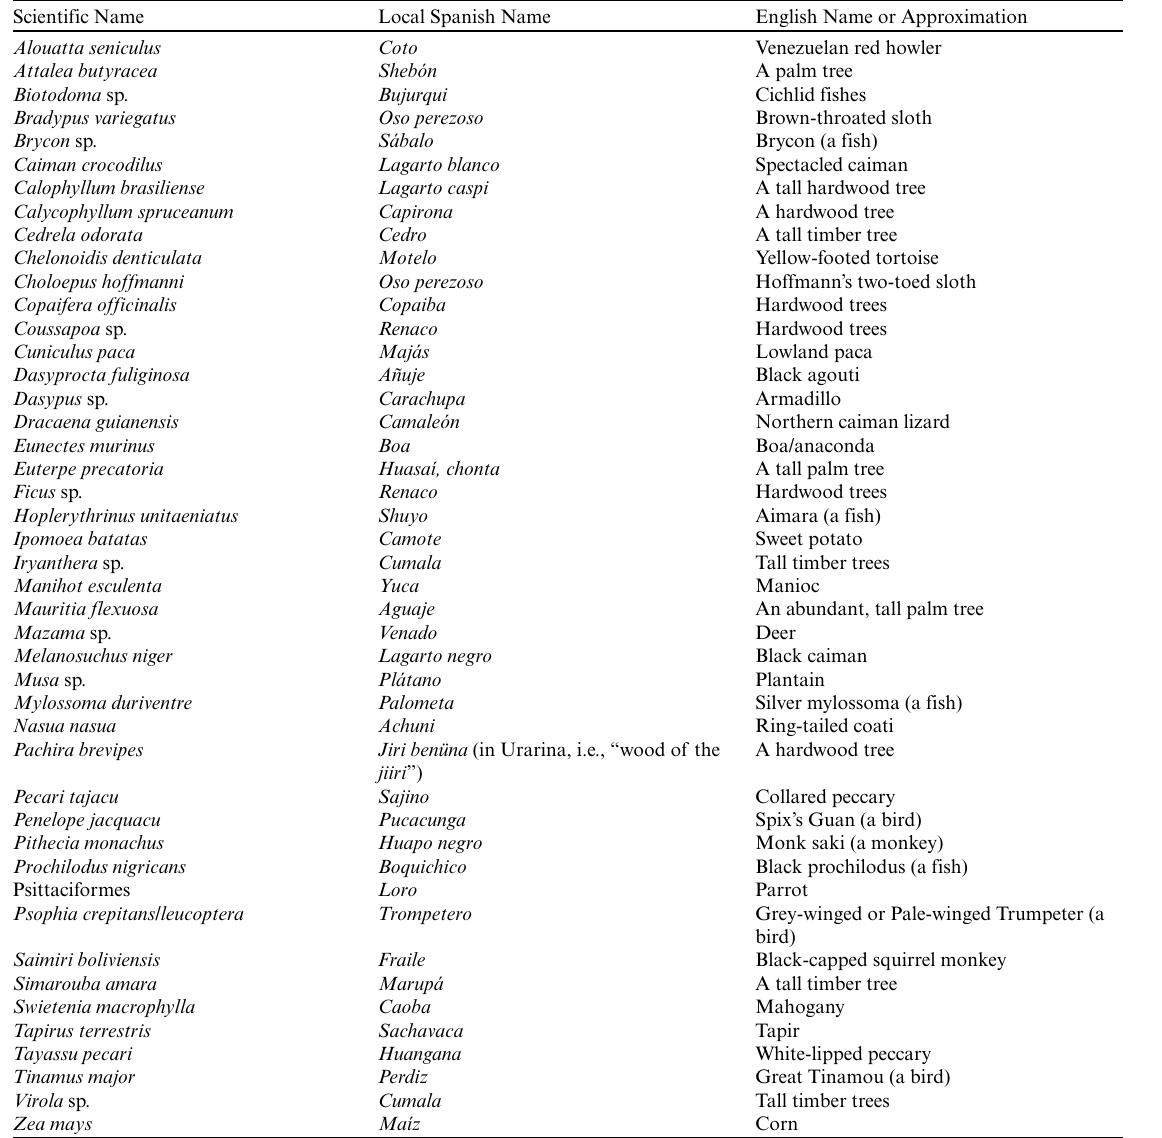
Table 1 . List of